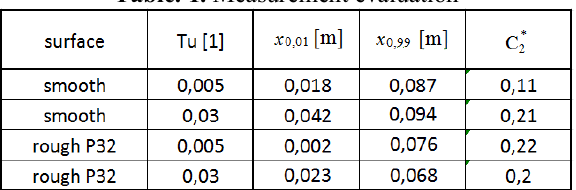
Table. 1. Measurement evaluation